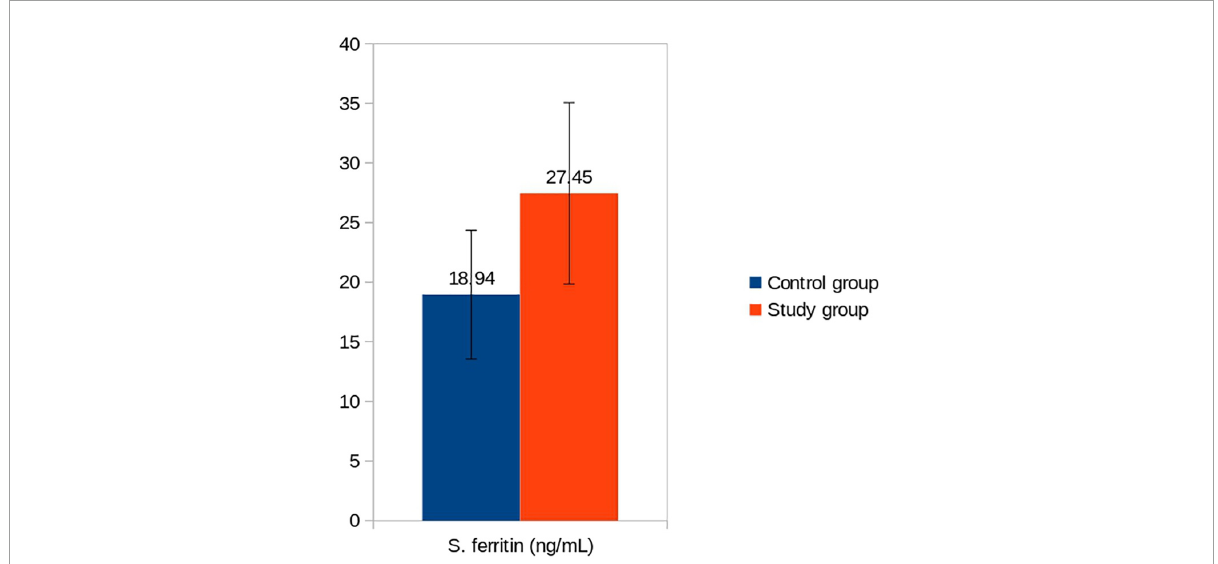
FIGURE2 Serum ferritin (ng/mL) of infants in control vs. study groups at 6 months. Serum ferritin: Control vs. Study group ( p < 0.001).